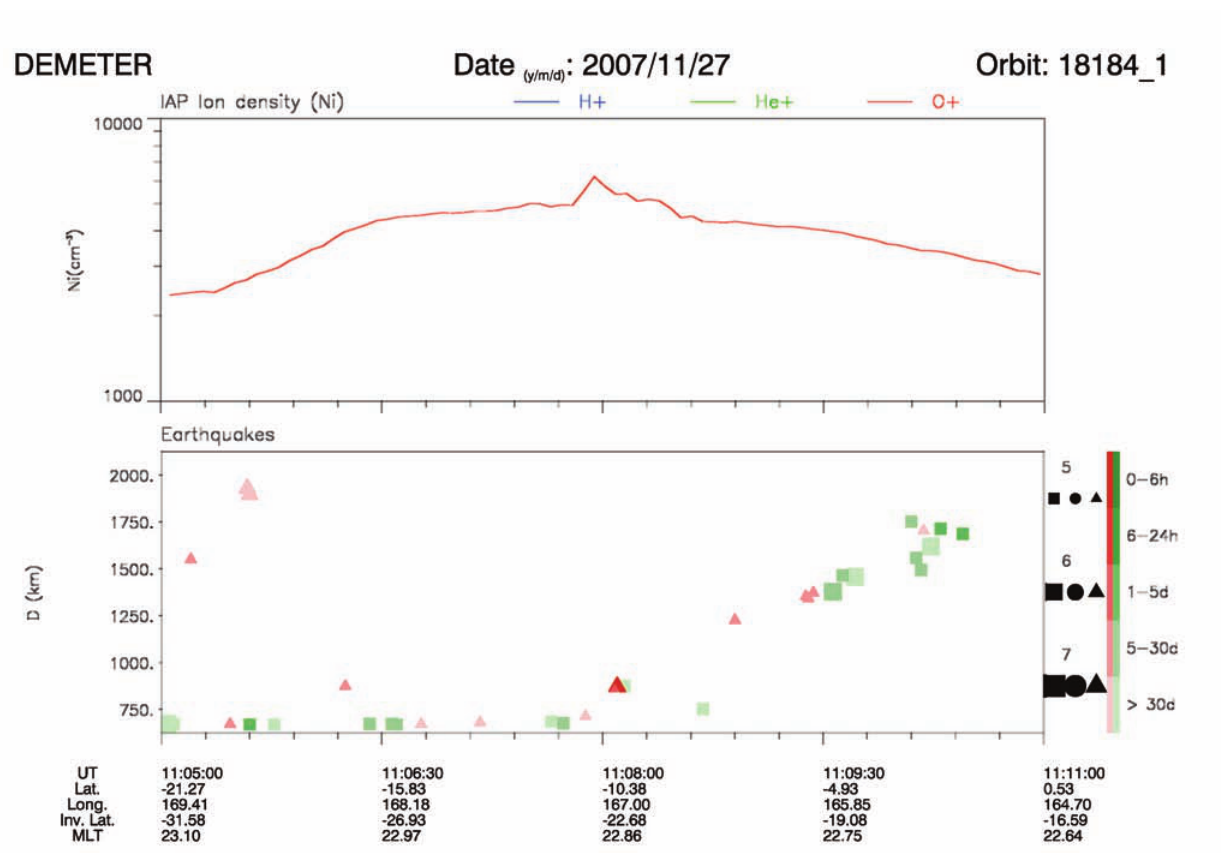
Figure 3. Data recorded on November 27, 2007, between 11:05:00 UT and 11:11:00 UT, a few tens of minutes before a M 6.6 earthquake, which occurred at 11:50:02 UT (latitude, –11.02˚S; longitude, 162.17˚E; depth, 41.6 km). See Figure 1 for